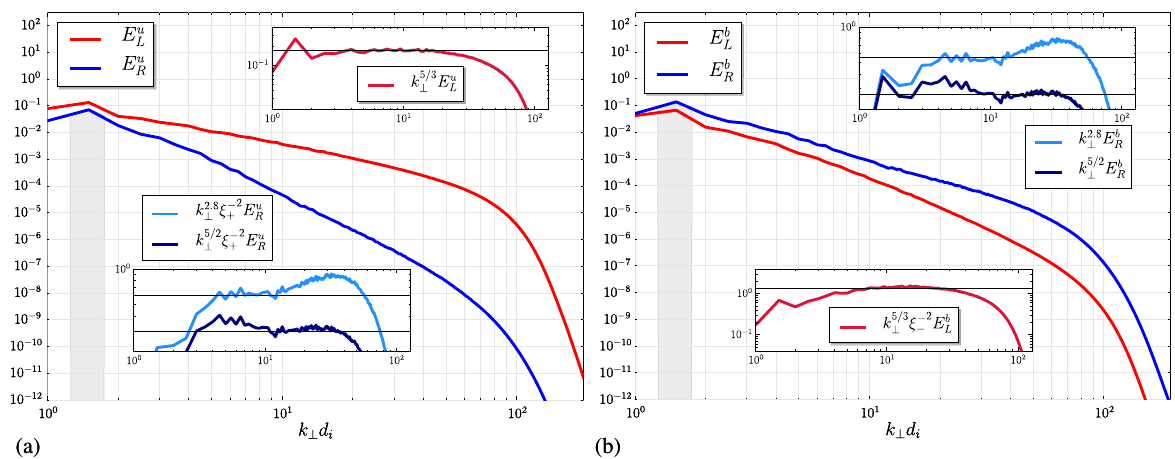
FIG. 2. (a) Transverse velocity spectra of the L fluctuations (red line) and R fluctuations (blue line) (run I). The grey column corresponds to the forcing scales, and the insets show L and R compensated spectra. (b) Same as Fig. 2(a) but for the magnetic L (red) and R (blue) fluctuation